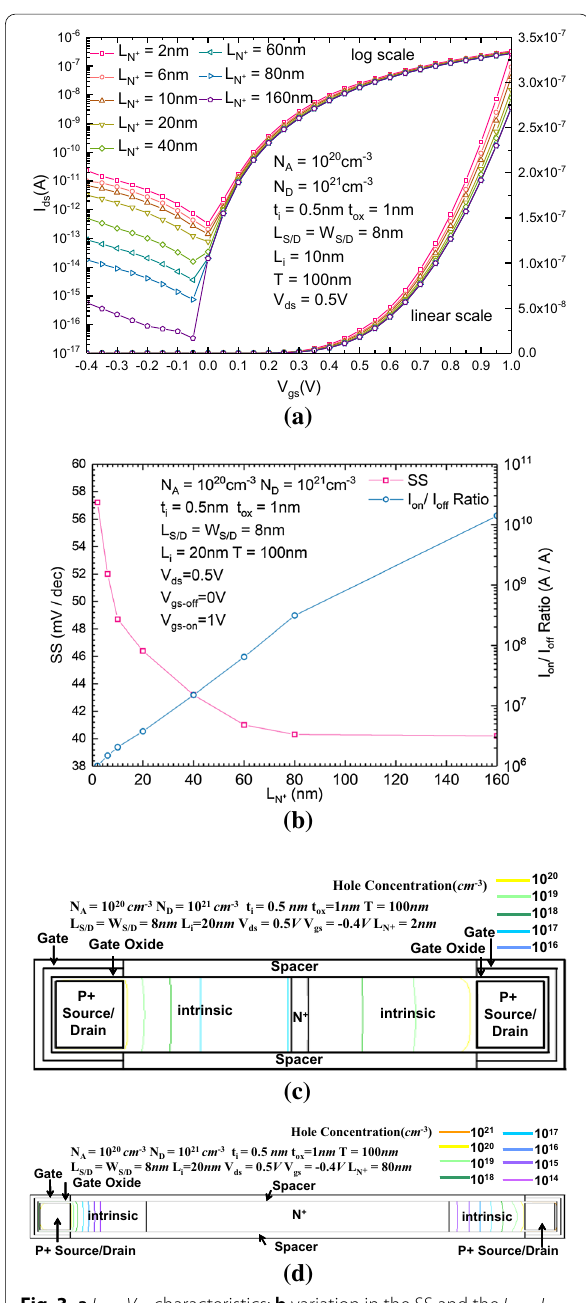
Fig. 3 a I ds − V gs characteristics; b variation in the SS and the I on − I off ratio of the proposed B‑TFET with different L N concentration distribution of the proposed B‑TFET under reversely biased for L N equal to (3) 2 nm and (4) 80 + N D ; the reversely 10 19 cm − 3 =